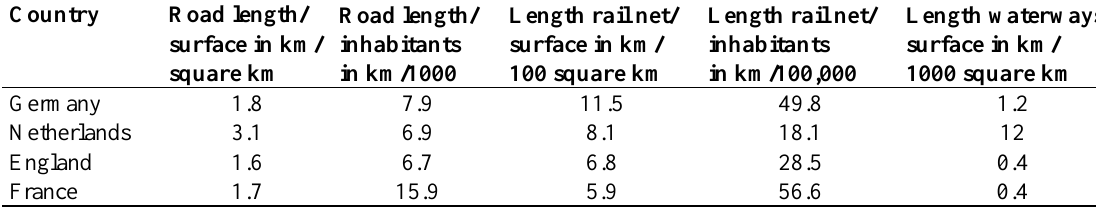
Table 7a. Size of the infrastructure networks I